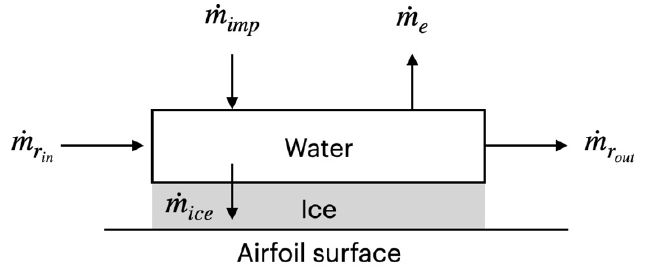
Figure 1. Schematic of parameters for the mass conservation in Messinger